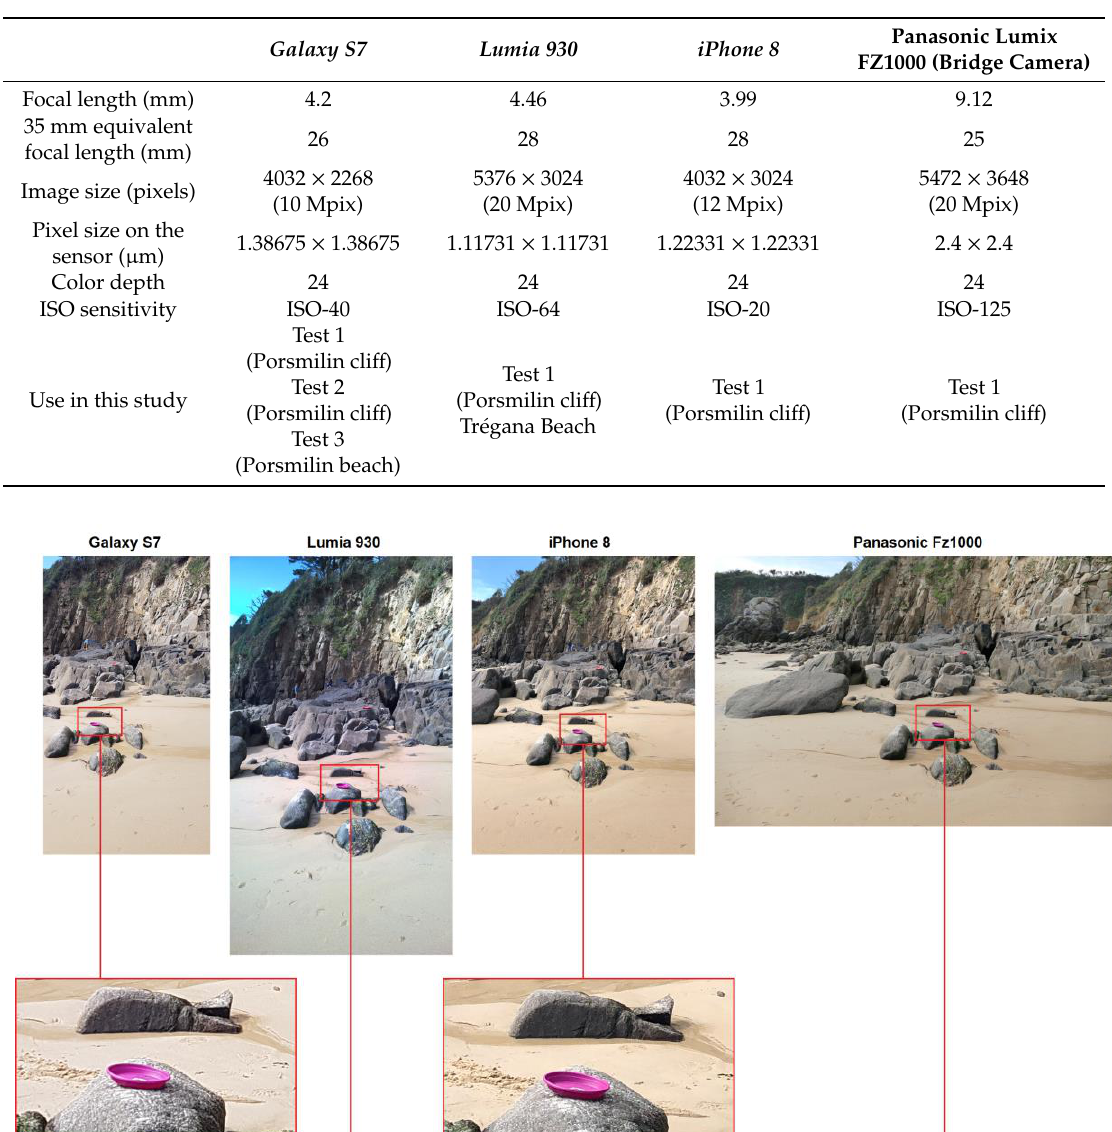
Table 1. Characteristics of various models of smartphone cameras and of a bridge camera.